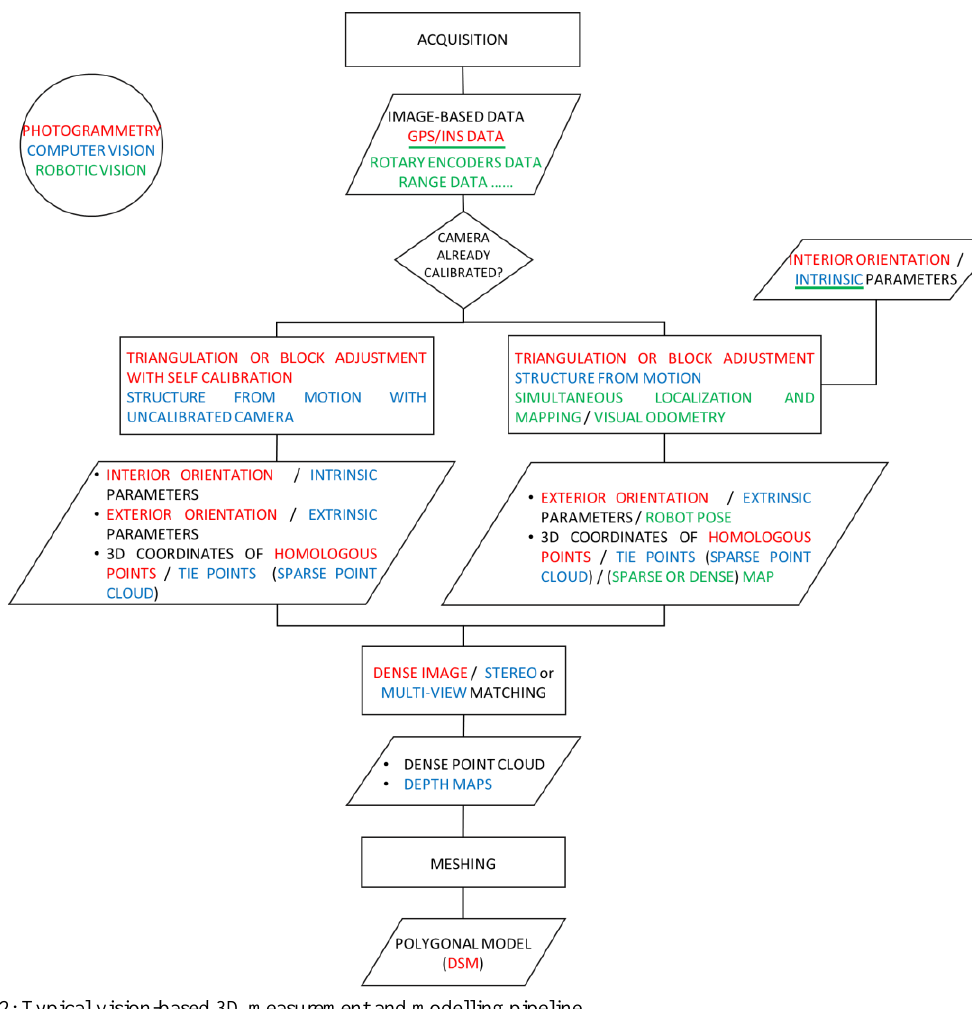
Figure 2: Typical vision-based 3D measurement and modelling pipeline.